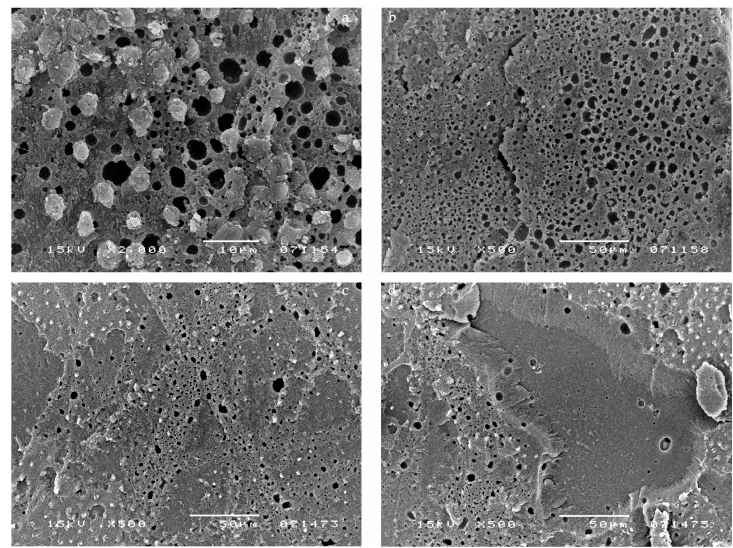
Figure 1. SEM photomicrographs illustrating the fractured surfaces for samples bonded with G-Bond. SEM analysis showed a large number of droplets within the adhesive layer of this DBA. Representative SEM images of G-Bond, applied without pulpal pressure (0 cm H 2 O), are shown in the ( a , b ) micrographs, where the presence of droplets at different levels throughout the adhesive layer can be seen (from 0.3 to 15 μ m). ( c , d ) Micrographs show a representative sample of G-Bond applied simultaneously to pulpal pressure (20 cm H 2 O). Many droplets comparable with those in the ( a , b ) micrographs were observed (from 2 to 36 μ m). Many droplets were displayed parallel to the scratches of the smear layer. SEM micrographs of failed bonds made with Clearfil S 3 Bond showed few small droplets within the adhesive layer of this DBA applied without pulpal pressure (0 cm H 2 O) (Figure 2a). Figure 2b shows a representative sample of Clearfil S 3 Bond when pulpal pressure was present. In contrast to the no pulpal pressure group, almost the entire adhe- sive layer was affected by voids. The micrographs in Figure 2c,d show the morphology of the adhesive layer when pulpal pressure was connected after DBA application and curing. A reduced number of voids was displayed. Materials 2021 , 14 , 6200